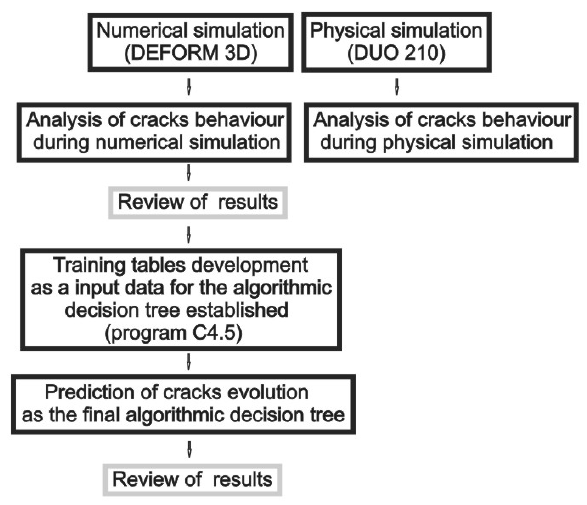
Figure 3. Processing